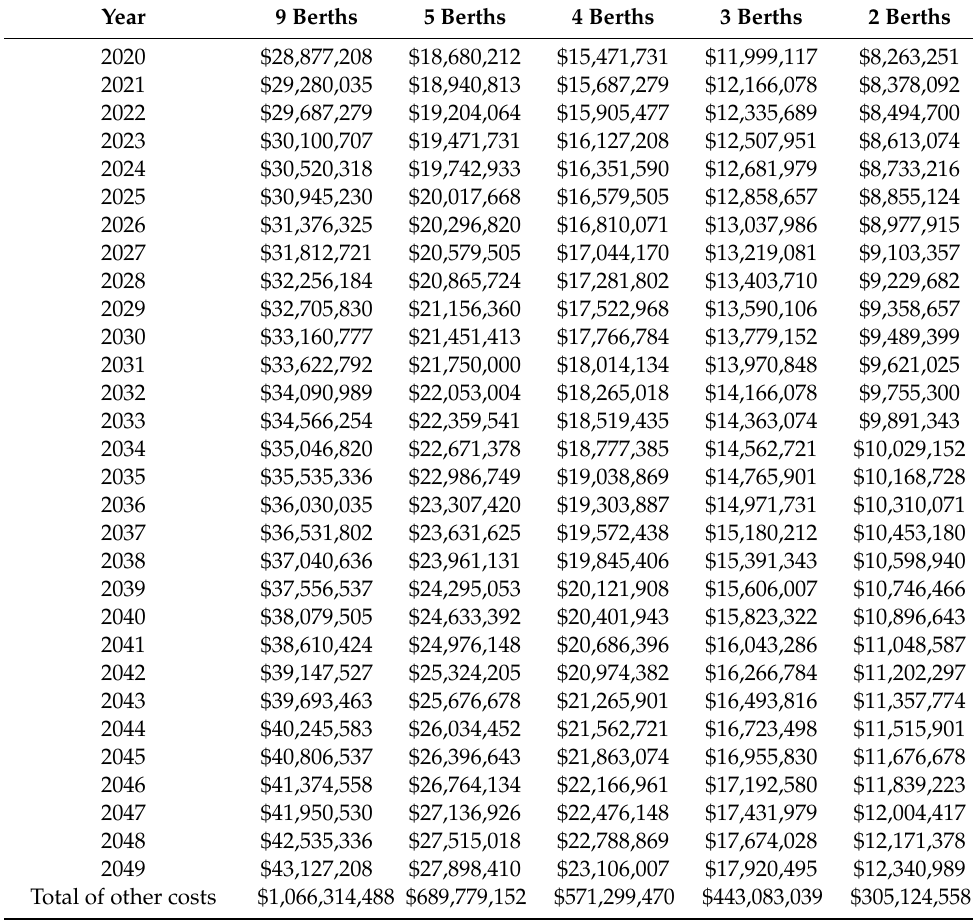
Table 8. Other cost (unit: U.S.